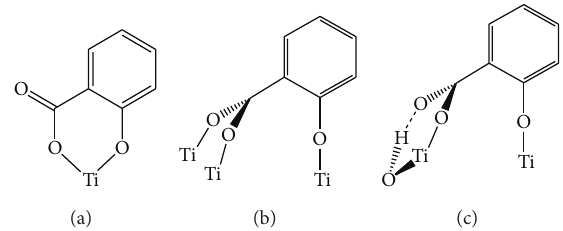
Figure 9: Binding schemes for the salycilate unit to the TiO 2